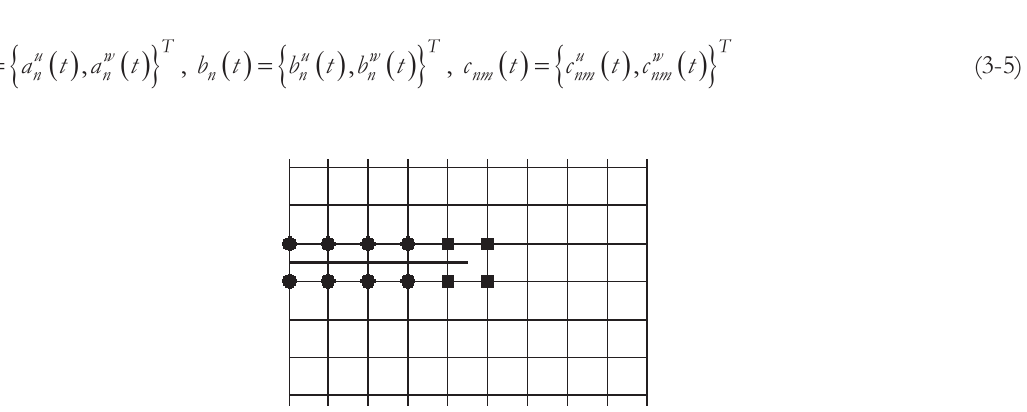
Figure 1: Selection of enriched nodes for crack. Circled nodes are enriched by the discontinuity function whereas the squared nodes are enriched by the crack tip enrichment